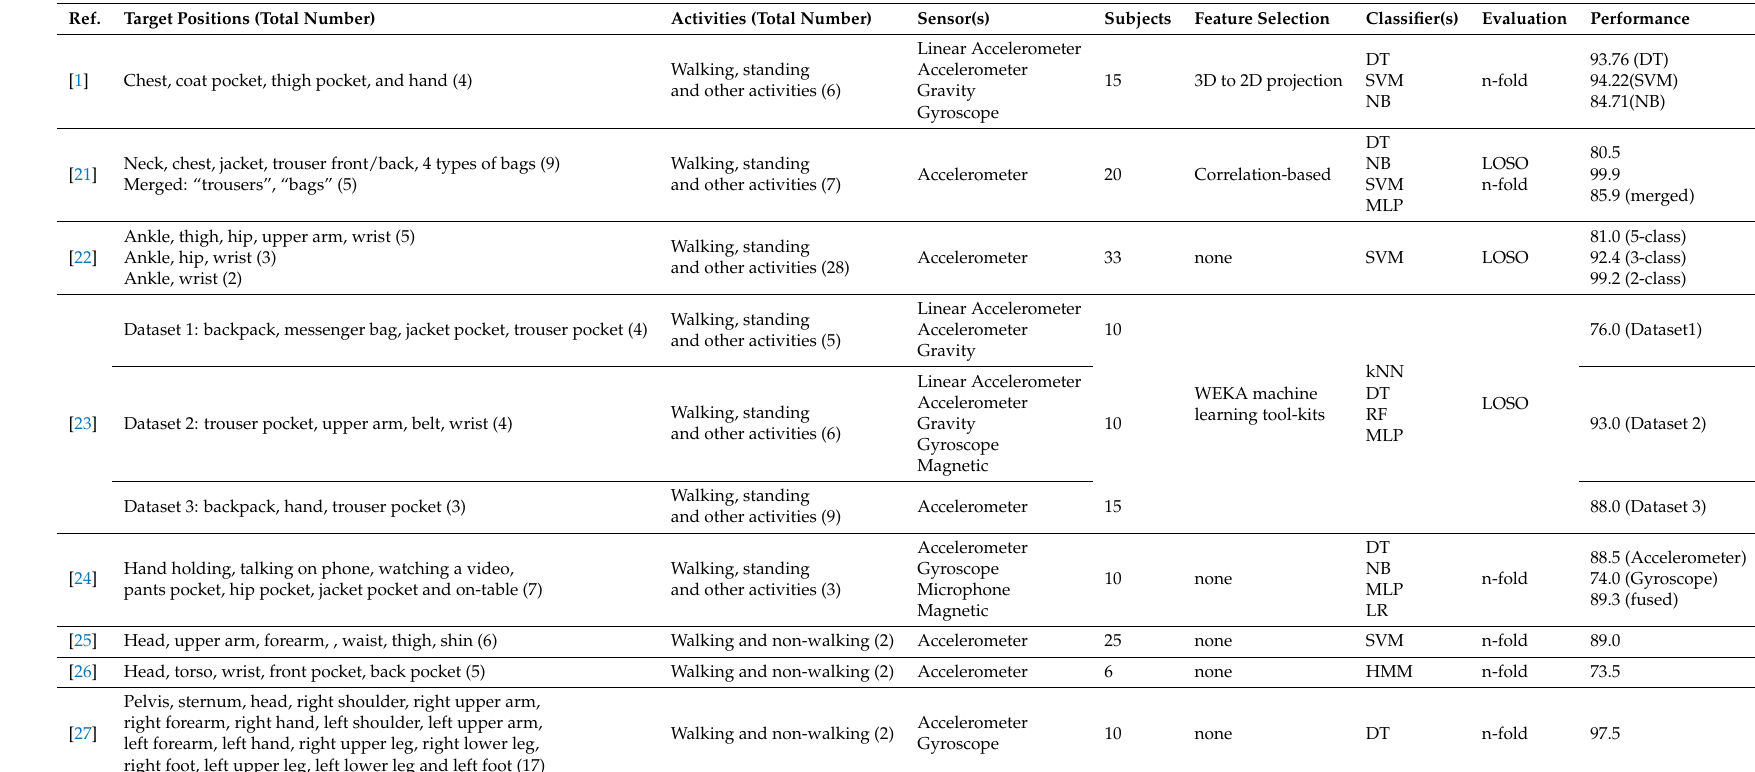
Table 1. Related works on sensor position